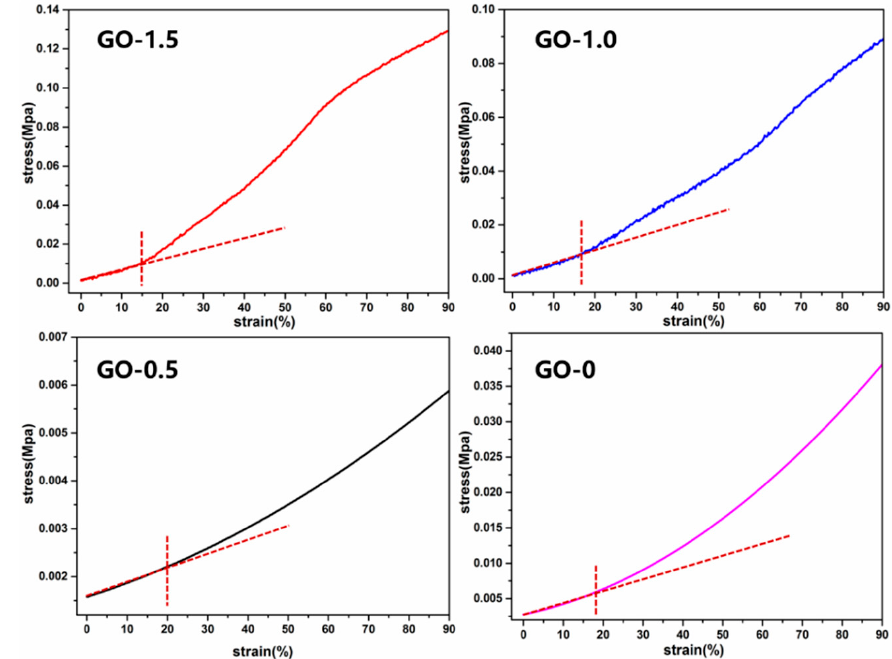
Figure 5. The elastic region for CSAs/GO aerogels. Table 2. The tensile strength